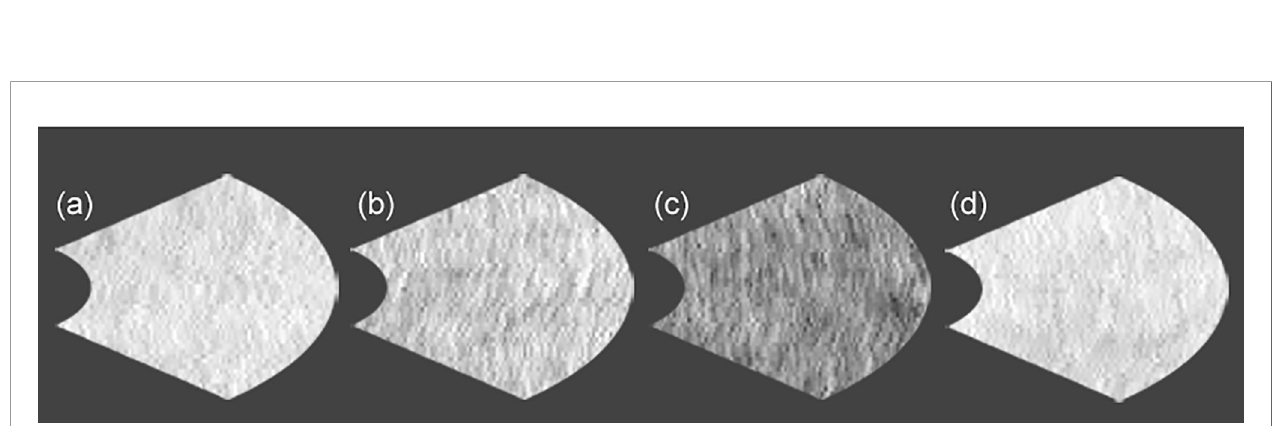
FIGURE 3 | Sequential changes for 2 years in the re fl ectance at grids de fi ned by Early Treatment Diabetic Retinopathy Study of individual macular photoreceptor layers and retinal pigment epithelium in patients with type 2 diabetes undergoing glycemic control (open circle) and control subjects (solid circle). Values were mean ± SEM. *p < 0.05 compared with endpoint, † p < 0.01 compared with 12 months, ‡ p < 0.05 compared with 12 months, § p < 0.05 compared with 6 months, װ p < 0.001 compared with 6 months, ¶ p < 0.01 compared with 6 months, # p < 0.05 compared with patients with type 2 diabetes, **p < 0.001 compared with patients with type 2 diabetes. AU, arbitrary unit; CF, central fovea; II, inner inferior; IN, inner nasal; IS, inner superior; IT, inner temporal; OI, outer inferior; ON, outer nasal, OS; outer superior; OT, outer temporal.